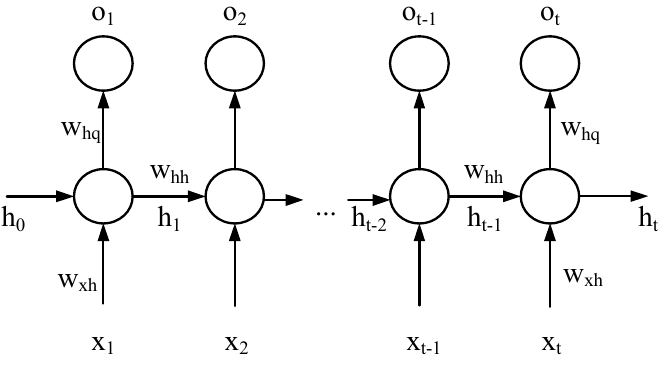
Figure 8. Recurrent Neural Unit Computational